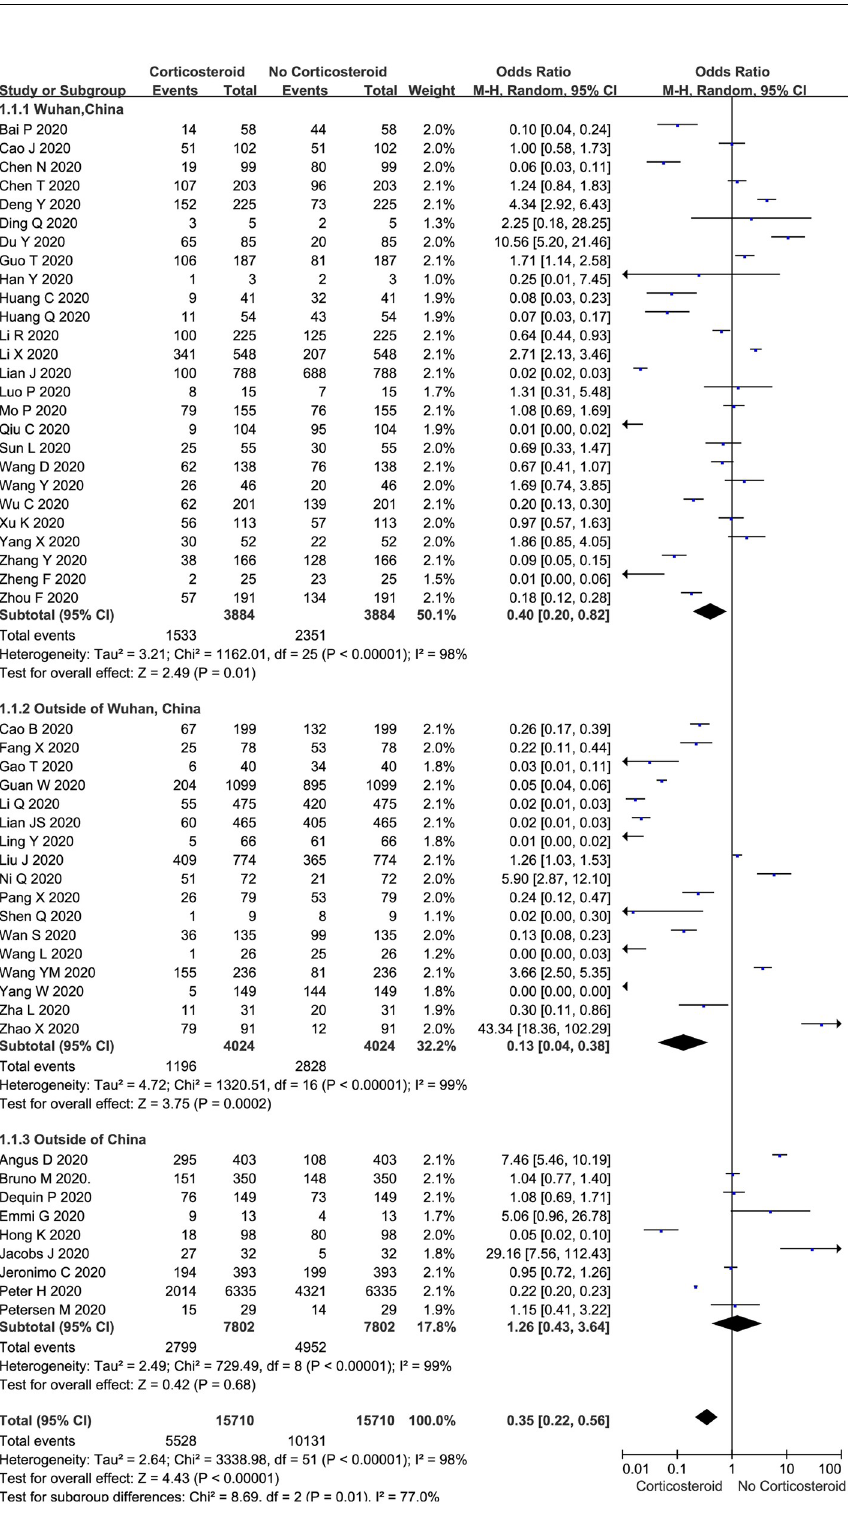
PLOS ONE | https://doi.org/10.1371/journal.pone.0249481 April 21,